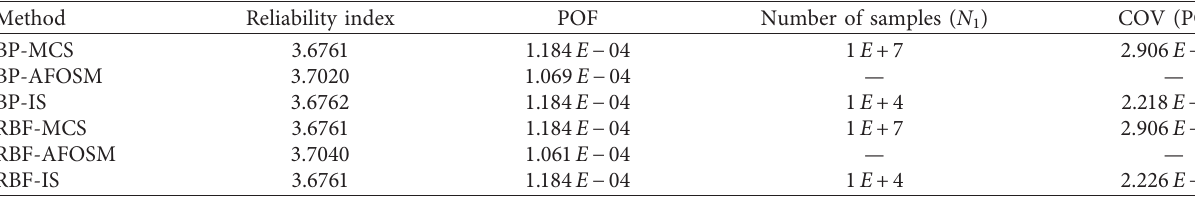
Table 11: Comparison of the reliability index and POF from different reliability analysis methods with an ANN sample size of 300.